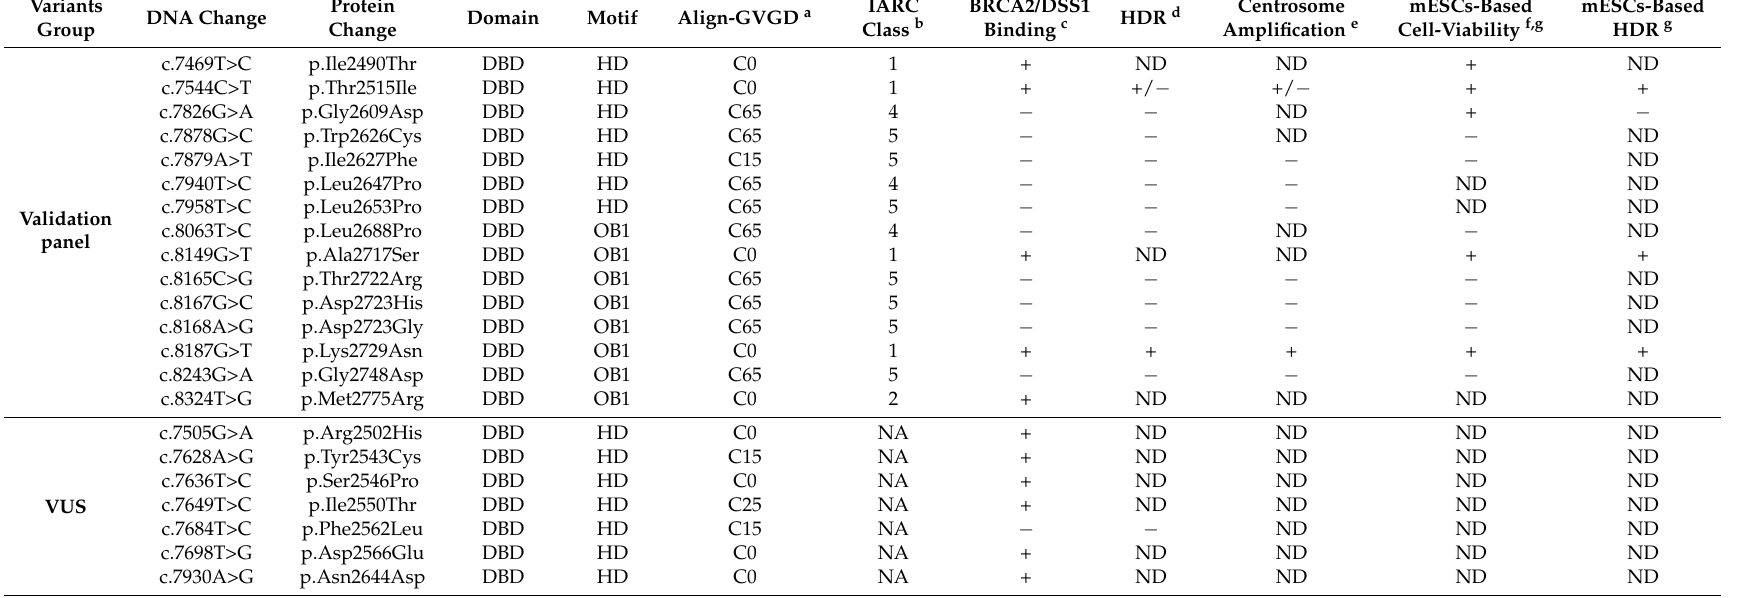
Table 4. BRCA2 variants analyzed with different functional